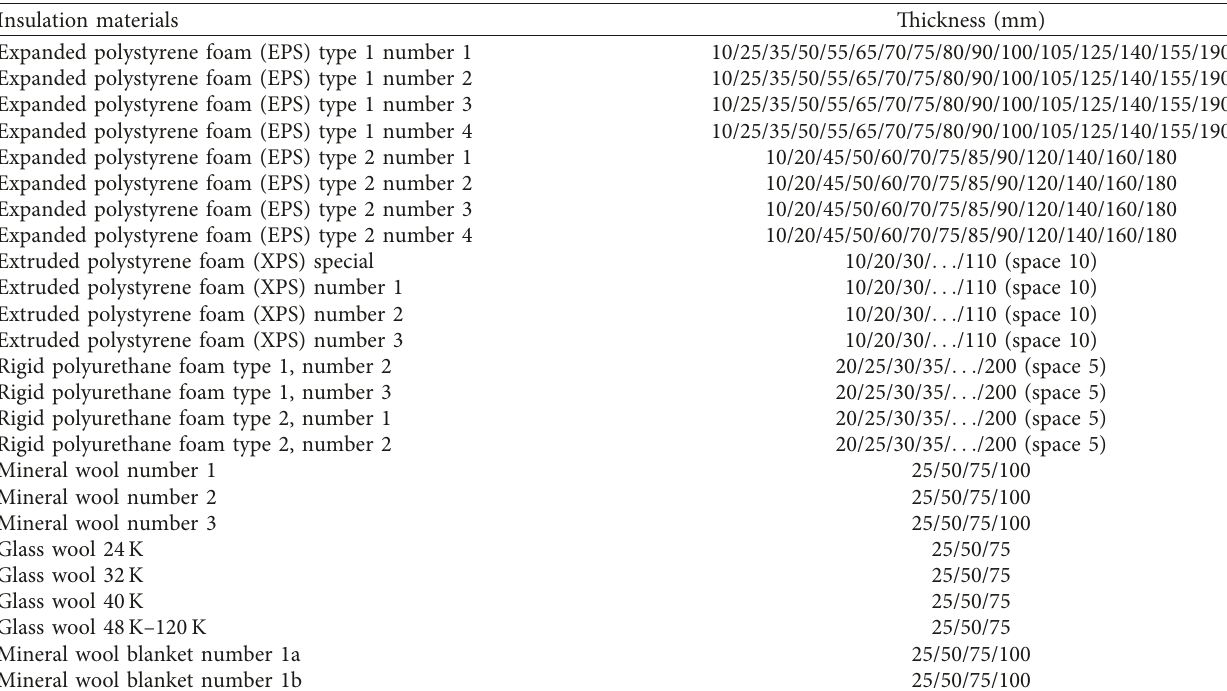
Table 1: Types and thickness of the insulation materials.